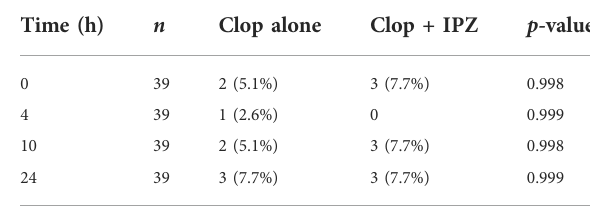
TABLE2HOPRstatusonbasisofMPAaftertheregimenofclopidogrel alone compared with coadministration of clopidogrel with